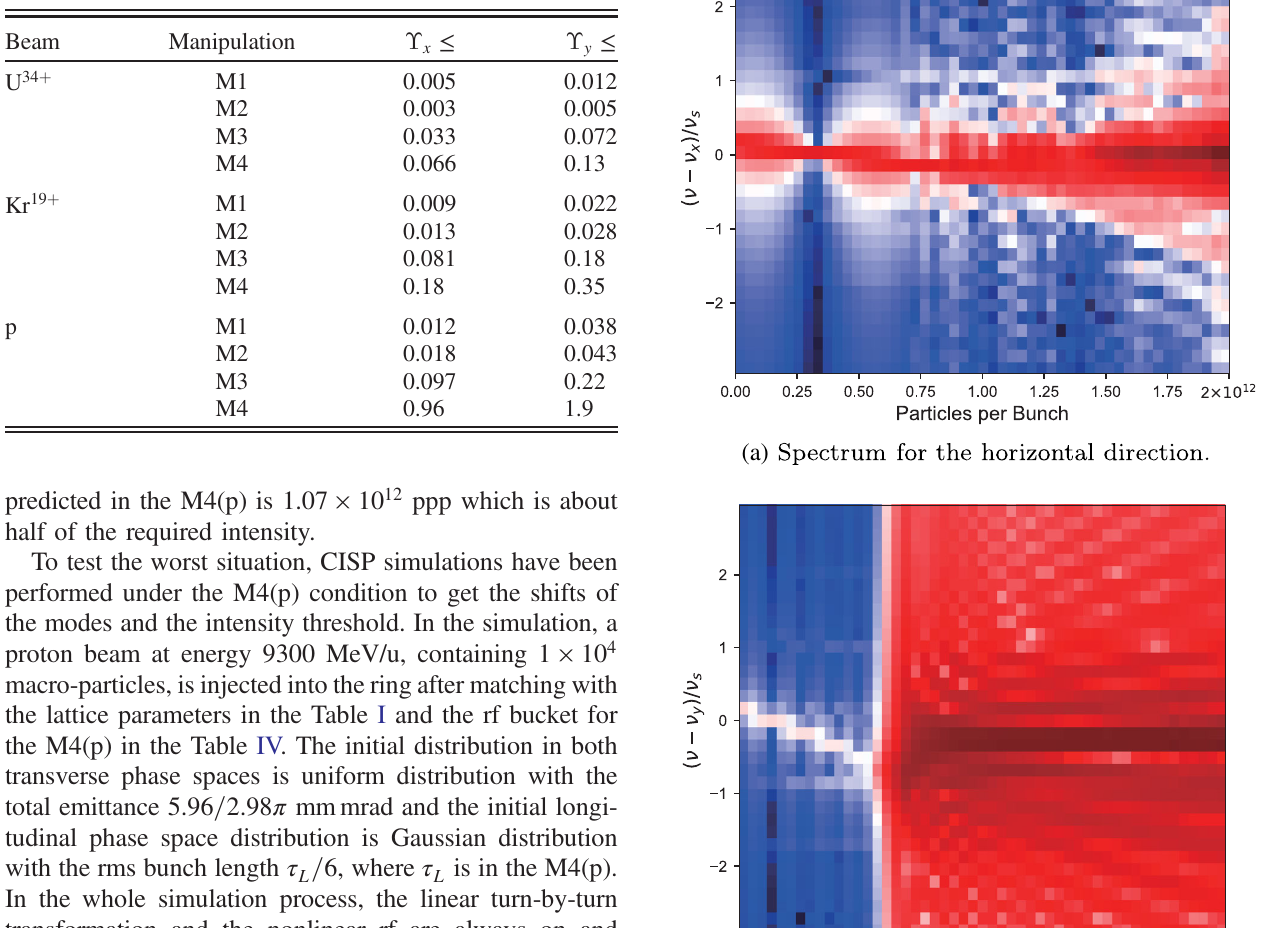
TABLE V. The ϒ for each manipulation with three reference beams.